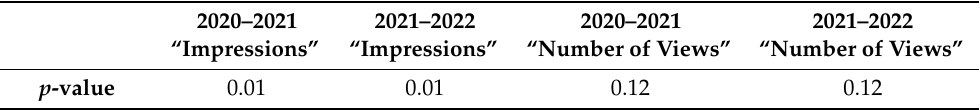
Table 4. Results of the F -test for the two normally distributed variables “Impressions” and “Number of views”.